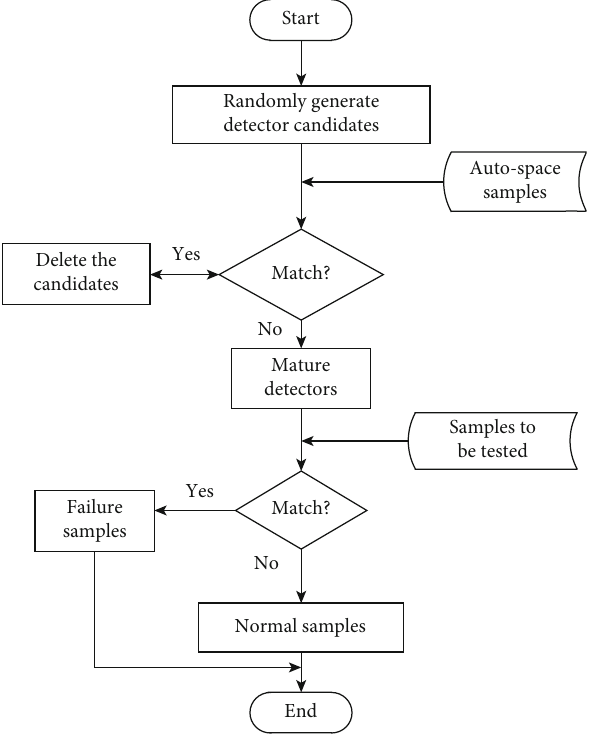
Figure 1: Flowchart of negative selection algorithm.